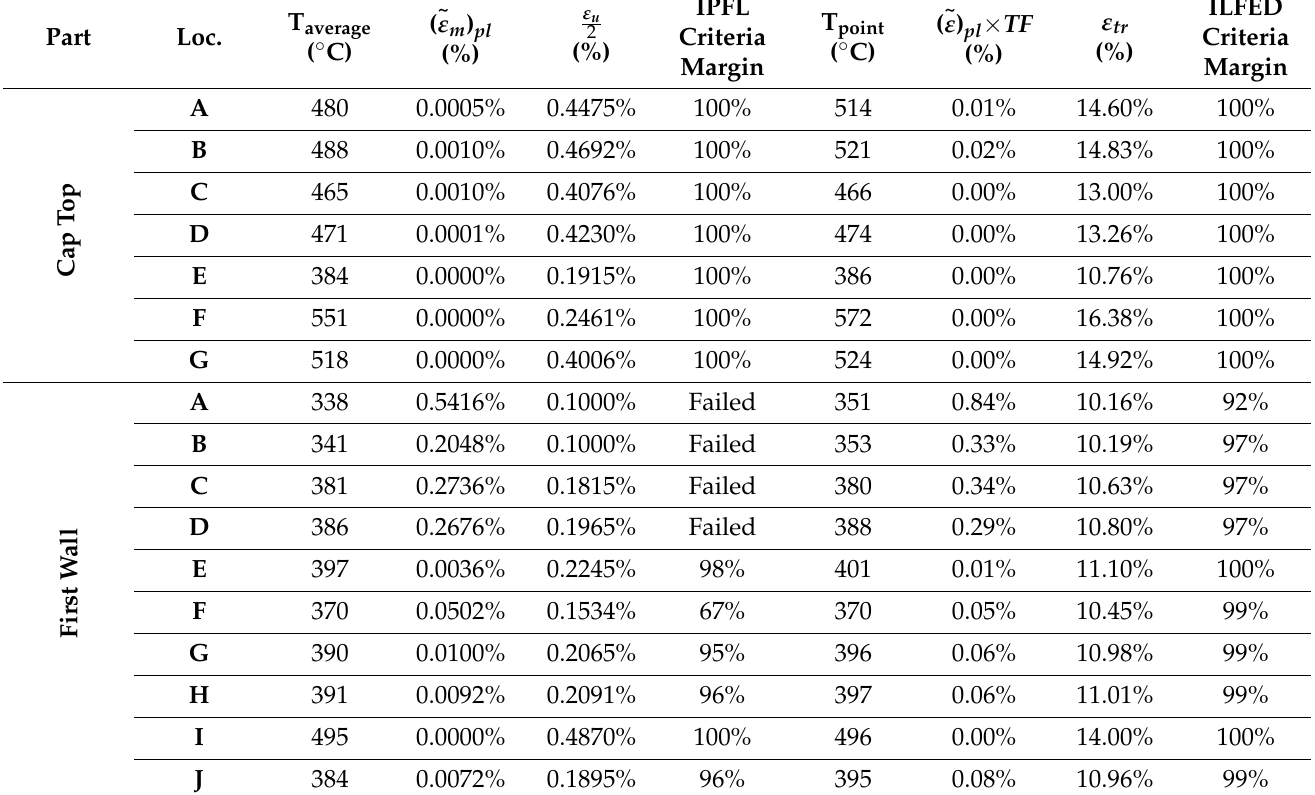
Figure 11. Stress triaxiality contour on BB cap region—inelastic analysis.